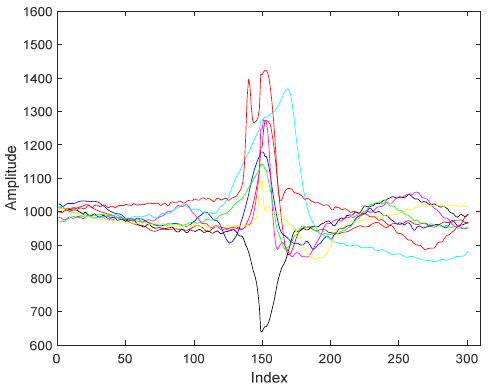
Figure 1. ECG patterns of the eight pattern classes